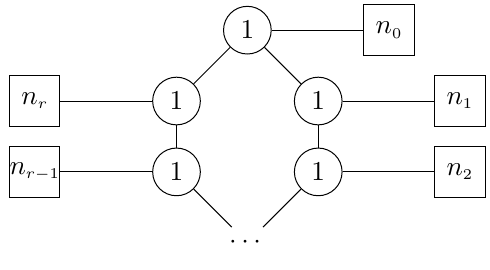
Figure 15 . Abelian b A r extended